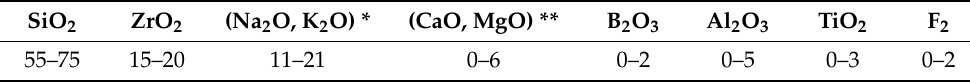
Table 1. Chemical composition of alkali-resistant (AR) fibers (%). * Alkali oxides, ** Alkaline earth